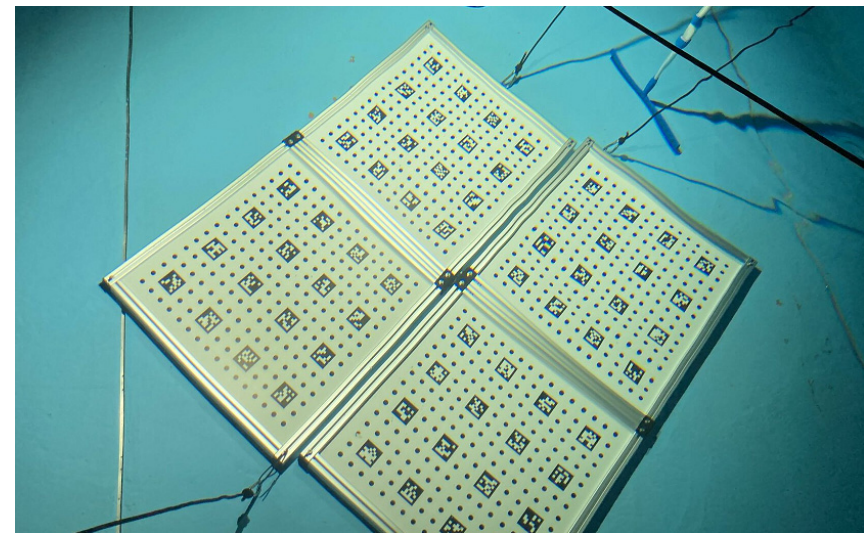
Figure 2. Sheets with ArUco markers combined with circle grids used for calibration.